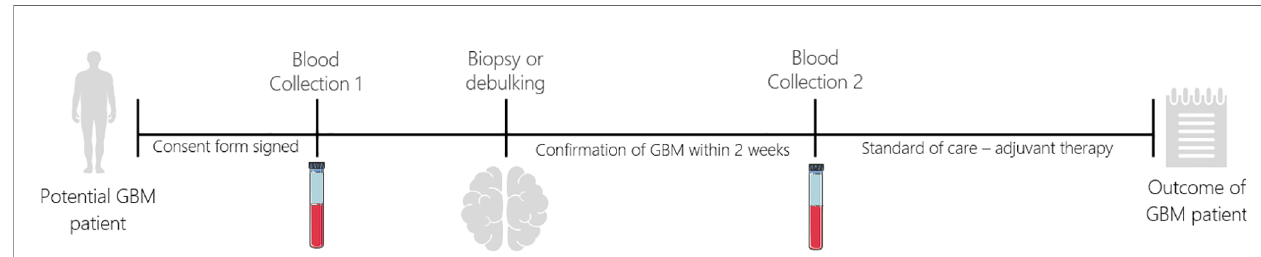
FIGURE 2 | Schematic overview of timepoints for blood collections in potential GBM